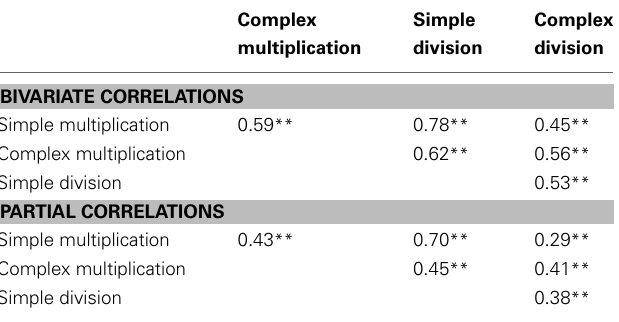
intelligence and verbal short-term memory) between arithmetic tasks.